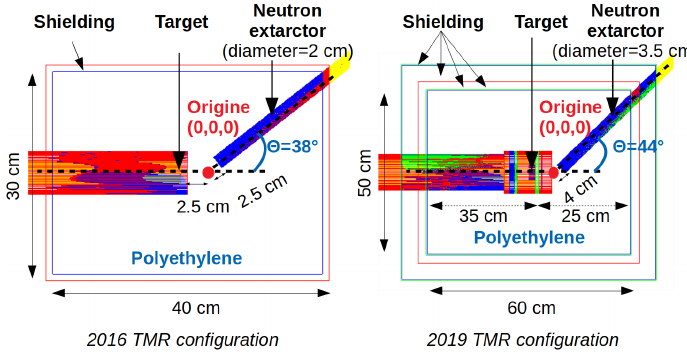
Figure 1: Sketches of the 2016 (left) and 2019 (right) TMR experimental configurations. The origin of the distance to neutron detectors is also indicated.